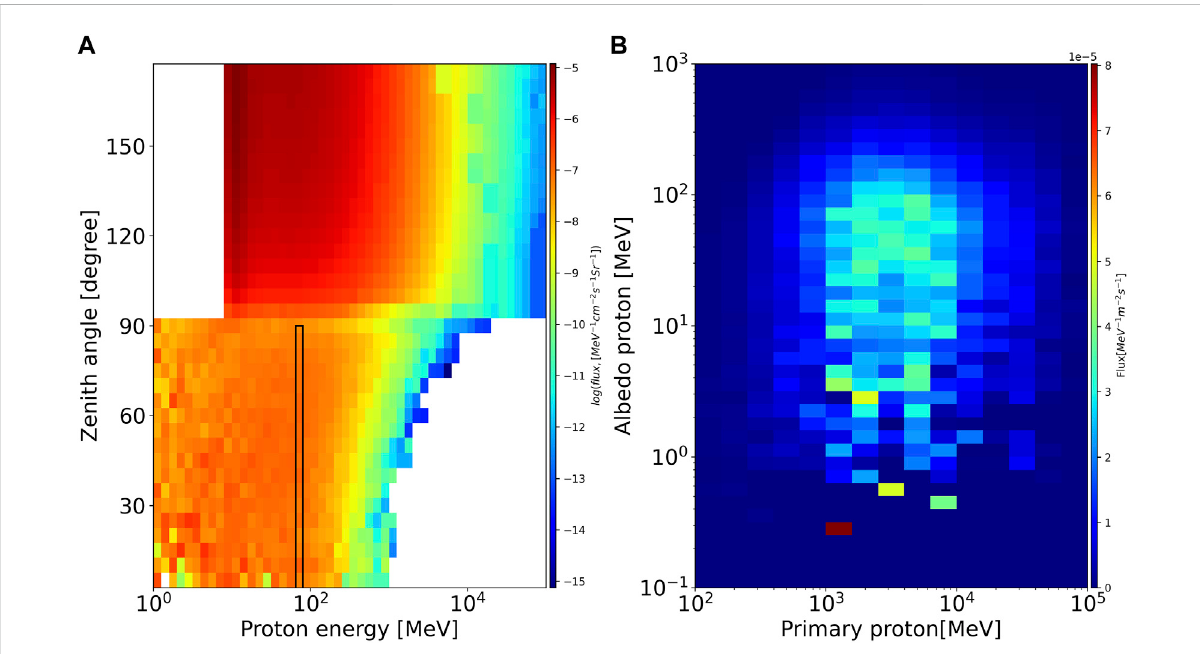
FIGURE 6 (A) Theangulardistributionofprotonsonthelunarsurfaceincludingbothalbedoprotons(0 – 90 ° )andGCRprimaryprotons(90 – 180 ° ).Theplot ismodi fi edfrom panel (a) ofFigure 4in Dobynde and Guo (2021). (B) :Albedo proton fl uxas afunction of primary protons shows amaximum around albedo energies of 80 MeV. These albedo particles are produced by primary protons with much higher energies. Both albedo particle distributions are derived by REDMoon